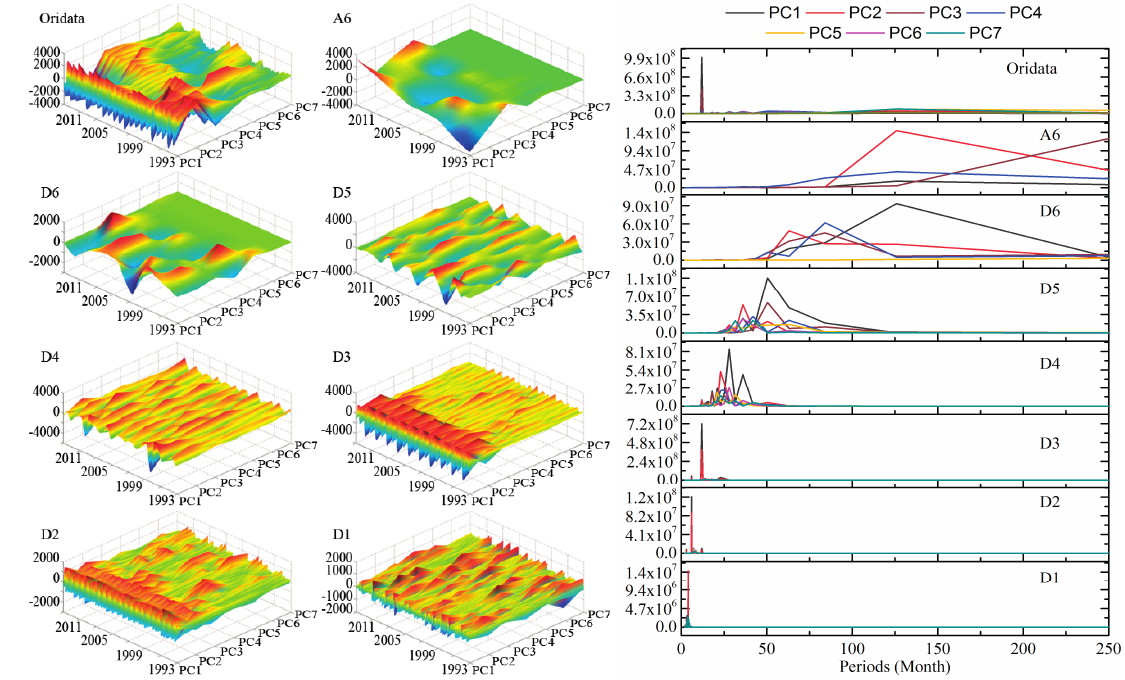
Figure 4. The principal components of original data and each decomposed components and their power spectrums. The 3D plot of the principal components of original data and each decomposed components ( left ); and the power spectrums of each decompose data of each principal component of original data and each decomposed component ( right ). The frequency is changed into period for better